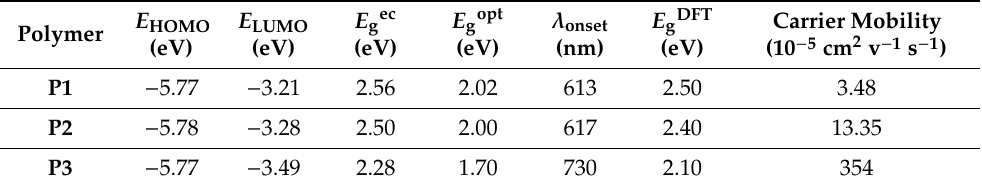
Table 1. Optical and electrochemical properties of the copolymers.